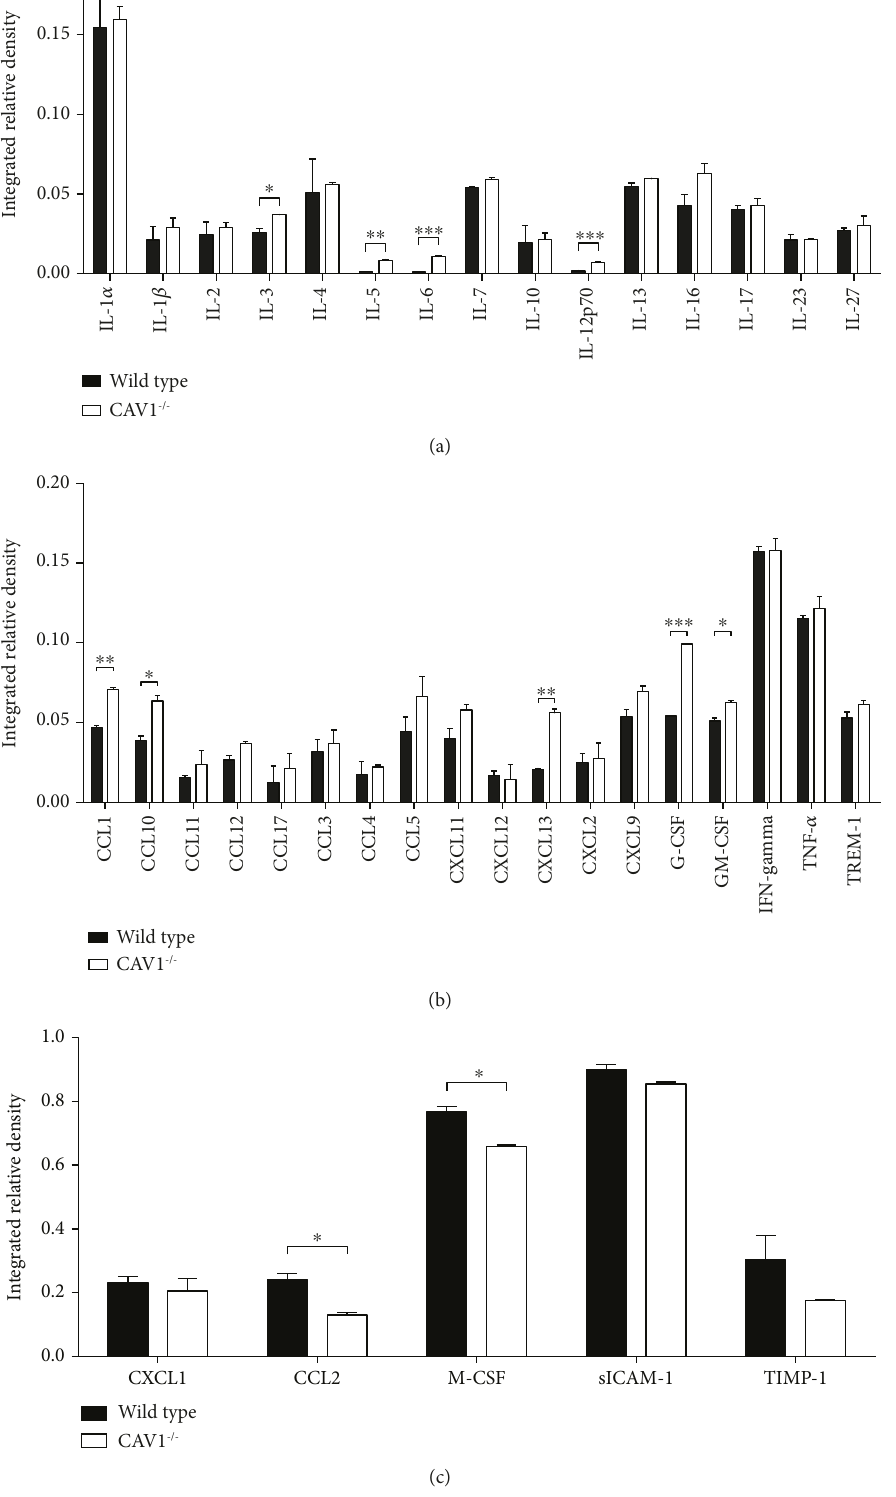
Figure 2: Relative expression levels of various mediators of in fl ammation. Pro- and anti-in fl ammatory cytokines (a), growth factors (b), and enzymes (c) involved in in fl ammatory processes were assessed in the plasma of the CAV1 − / − and control mice using the Proteome Pro fi ler. The data represent the average of the experiments. ∗ p < 0 05 , ∗∗ p < 0 01 , and ∗∗∗ p < 0 001